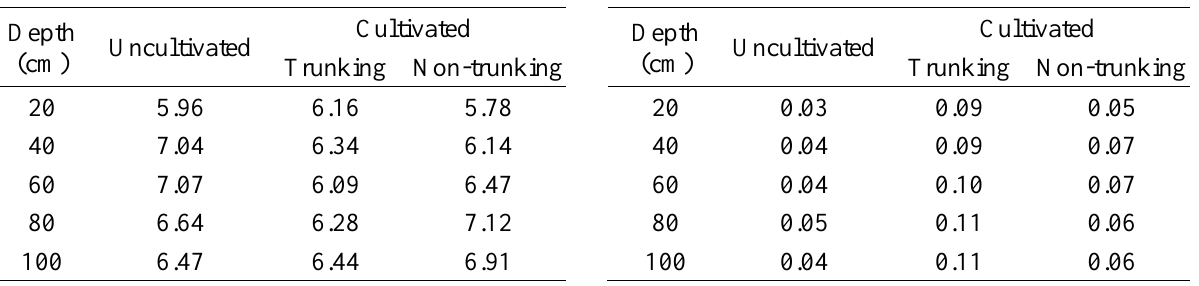
Table 3. Absorbance at 540 nm for humic acid extracted from uncultivated and cultivated peat, according to